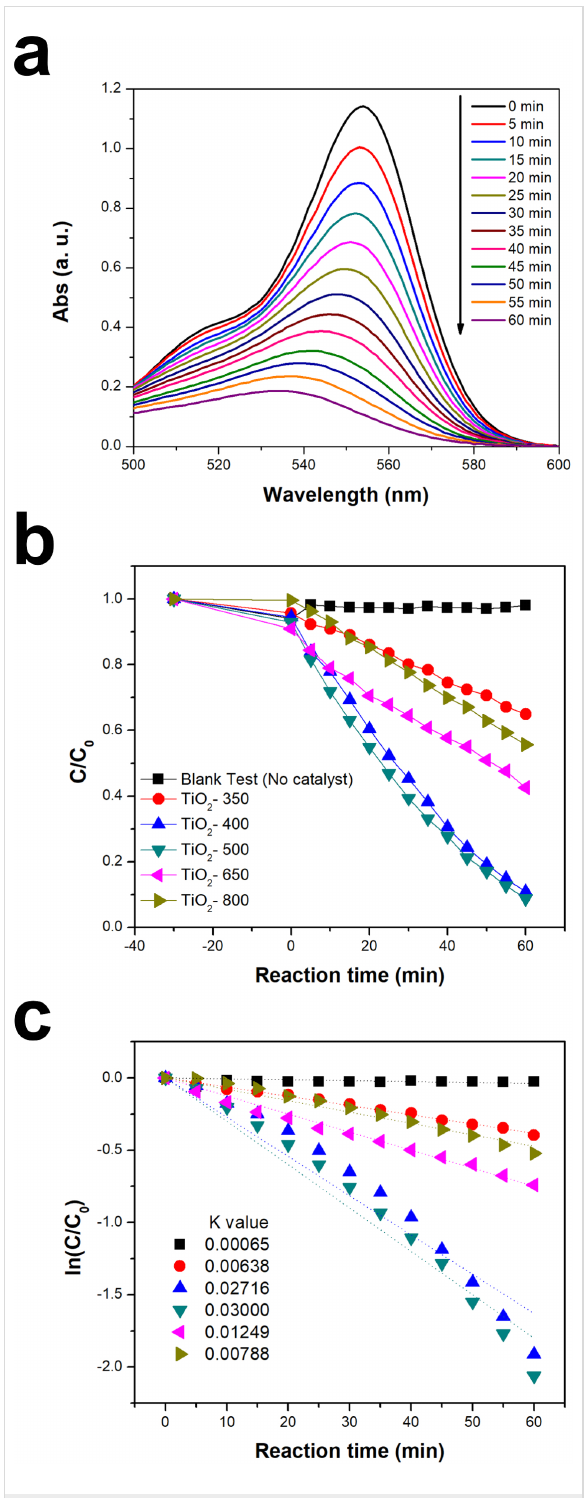
Figure 6: (a) UV–vis absorption spectra indicating degradation of rhodamine B (RhB) using the TiO 2 -500 sample, (b) photocatalytic deg- radation of RhB under UV–vis light irradiation and (c) semilogarithmic plot versus time for the different TiO 2 samples: Blank Test (no catalyst) ( ■ ), TiO 2 -350 ( ● ), TiO 2 -400 ( ▲ ), TiO 2 -500( ▼ ), TiO 2 -650 ( ◄ ) and TiO 2 - 800 ( ►